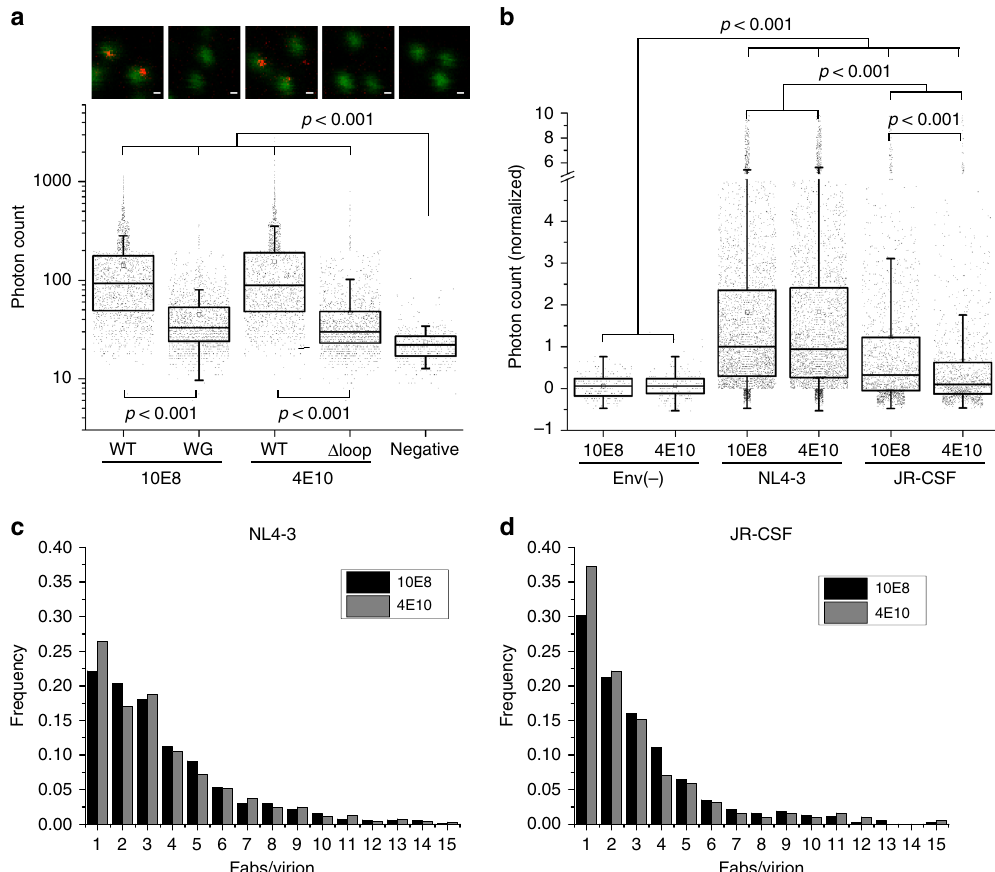
Fig. 4 Differential binding of anti-MPER antibodies 10E8 and 4E10 to virions as revealed by quantitative STED microscopy. a Representative images of virions (Vpr.GFP, green) and antibodies (KK114, red) (top) and measured KK114 intensities (bottom) for 10E8 WT ( n = 776), 10E8 WG ( n = 1375), 4E10 WT ( n = 644), and 4E10 Δ loop ( n = 1109). Each point in the bottom plot represents the KK114 intensity sum measured in a single viral particle. Negative samples ( n = 795) were measured in the absence of labeled antibody. Data from a single experiment. b 10E8 and 4E10 STED signals measured in Env(-) ( n = 223 and 202), Env NL4-3 ( n = 3336 and 3165), and Env JR-CSF ( n = 1664 and 1303) HIV-1 virions. For the matter of comparison signals from single virions from two or more independent experiments have been normalized to 10E8-Env NL4-3 signal after background subtraction. Histograms displaying F/v frequencies measured for both antibodies (50 ng μ L − 1 ) in NL4-3 ( c ) and JR-CSF ( d ) viruses. The statistical signi fi cance was assessed by Kruskal – Wallis one-way analysis of variance. If not noted otherwise, differences were not signi fi cant at the 0.05 level. In a and b results are shown in box-plots (center line, median; square, mean; box, IQR; whiskers, upper and lower inner fences). Scale bars are 100